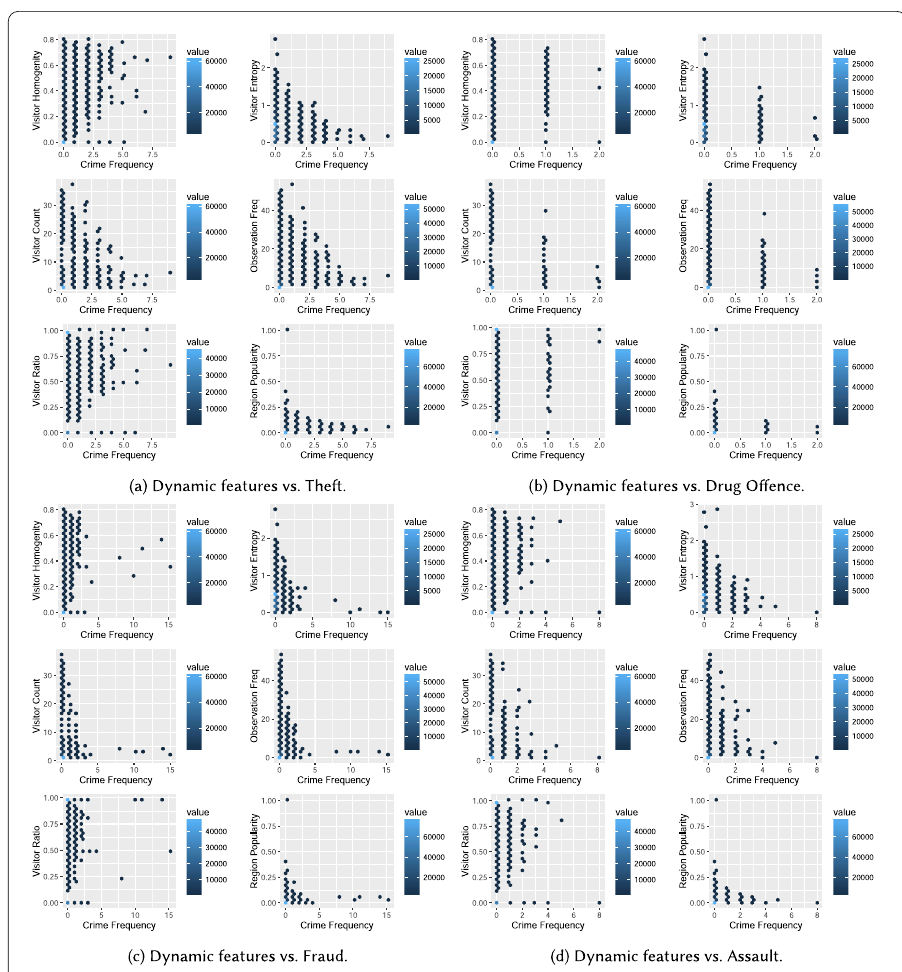
Figure 4 Correlation between dynamic features and crime event occurrences in the interval [21–24) in New York